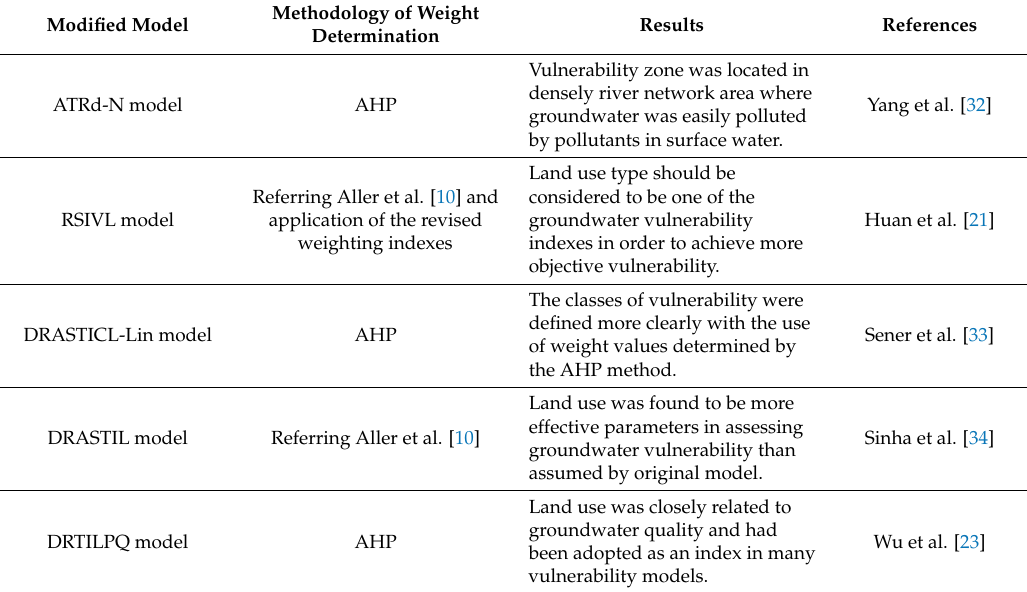
Table 1. Groundwater vulnerability assessments conducted by modified DRASTIC